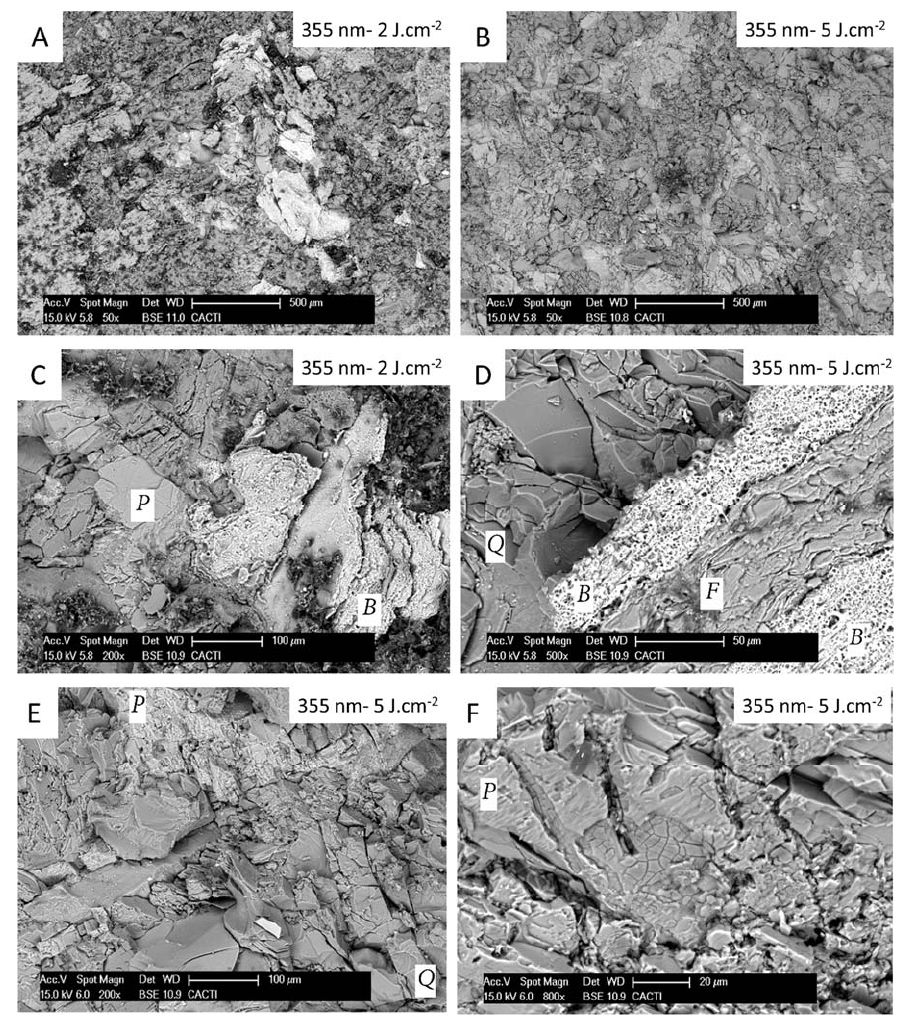
Figure 6. SEM micrographs of the treated surfaces with an Nd:YAG laser working at 355 nm at two different fluences (2 and 5 J ∙ cm − 2 ). B: biotite, P: plagioclase, F: feldspar; Q: quartz.